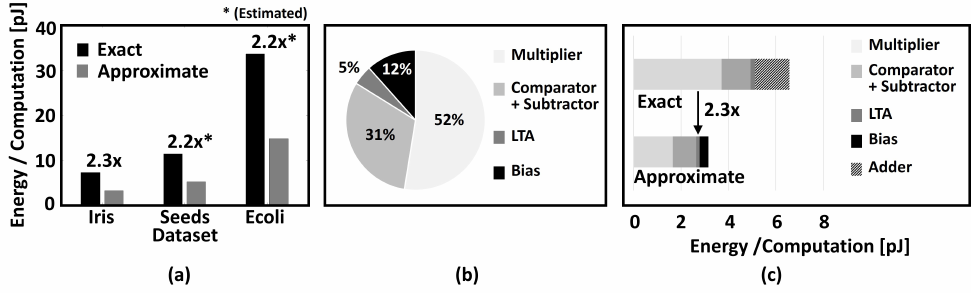
Figure 14. ( a ) Comparison of the energy consumption of the proposed distance computing unit with respect to digital CMOS technology; ( b ) energy consumption of each component of the proposed design; ( c ) component-wise energy comparison with digital CMOS